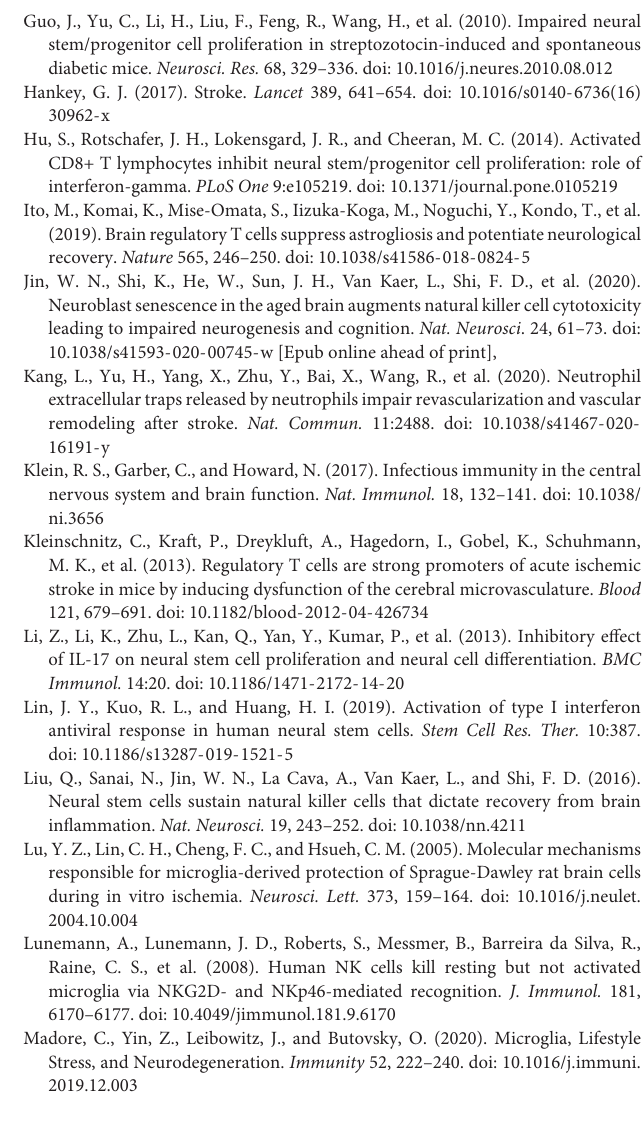
Supplementary Figure 1 | Mice without induced dMCAO model have few CD11b − CD45 + lymphocytes in their brains. (A) A flow cytometry diagram showed that the brain cells in the sham group were screened by CD45 and CD11b antibodies after removing the dead cells, and there were few lymphocytes except microglia cells. Supplementary Figure 2 | Perforin + CD45 + cells secreted IFN- γ and IL-17. (A) Flow diagram showing the gating strategy of Perforin + CD45 + cells and their subsets. (B) The cytokine secretion of Perforin + CD45 + cells and their subsets were shown by histogram. (C) This statistical chart shows the number of IL-17A or IFN- γ in Perforin + CD45 + and their subsets cells in ischemic stroke area at day 14. The data are shown as the median and the value of min to max; n = 8 animals in each